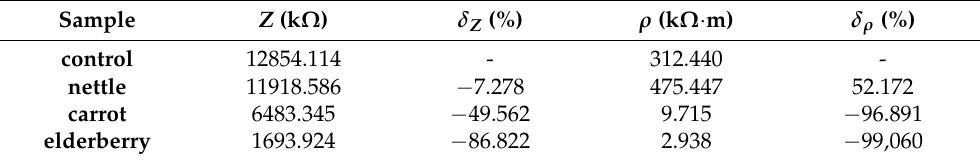
Table 8. Relative differences of impedance δ Z and resistivity δ ρ compared to the